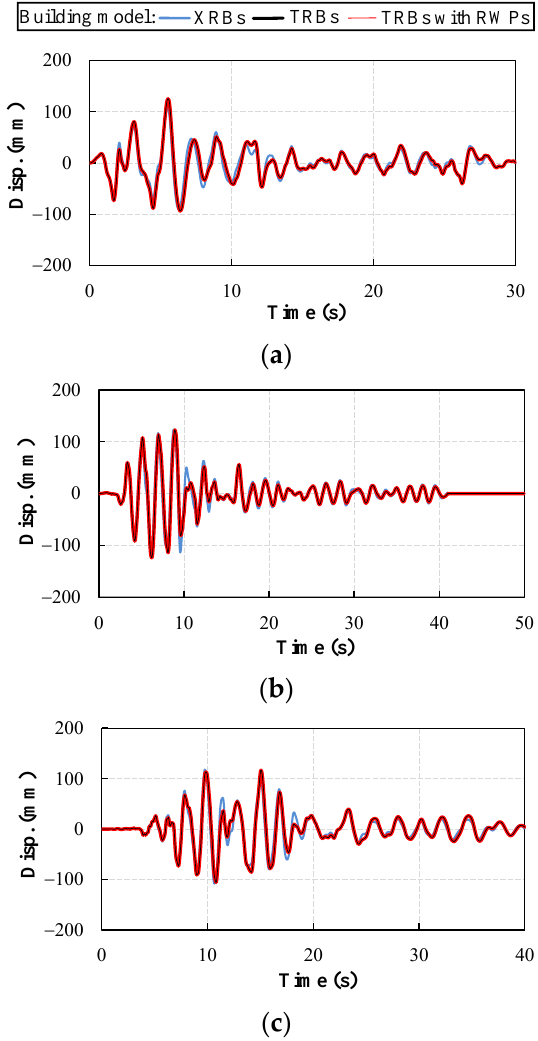
Figure 6. Displacements of the 1st floor under the ground motions at a 2–3% PE in 50 years: ( a ) El Centro; ( b ) Kobe; ( c )